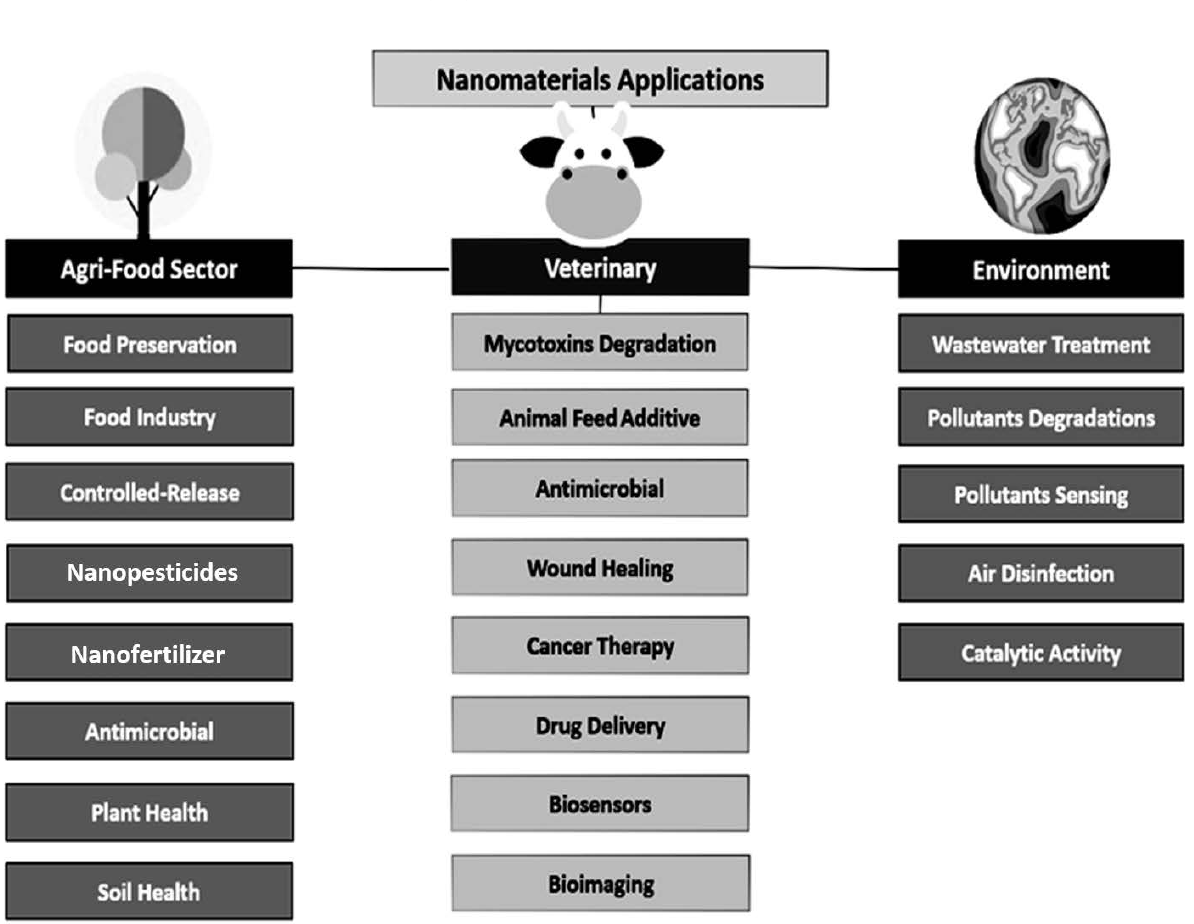
Figure 7. Applications of Nanotechnology in agri-food, veterinary medicine, and